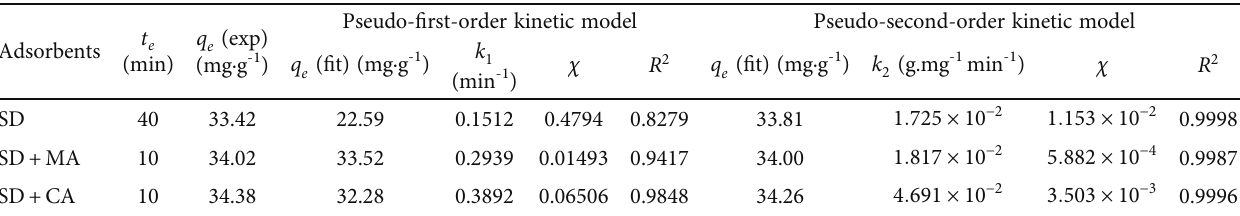
Table 4: Kinetic parameters of adsorption of boron chloride on SD, SD+ MA, and SD +CA. Adsorbents